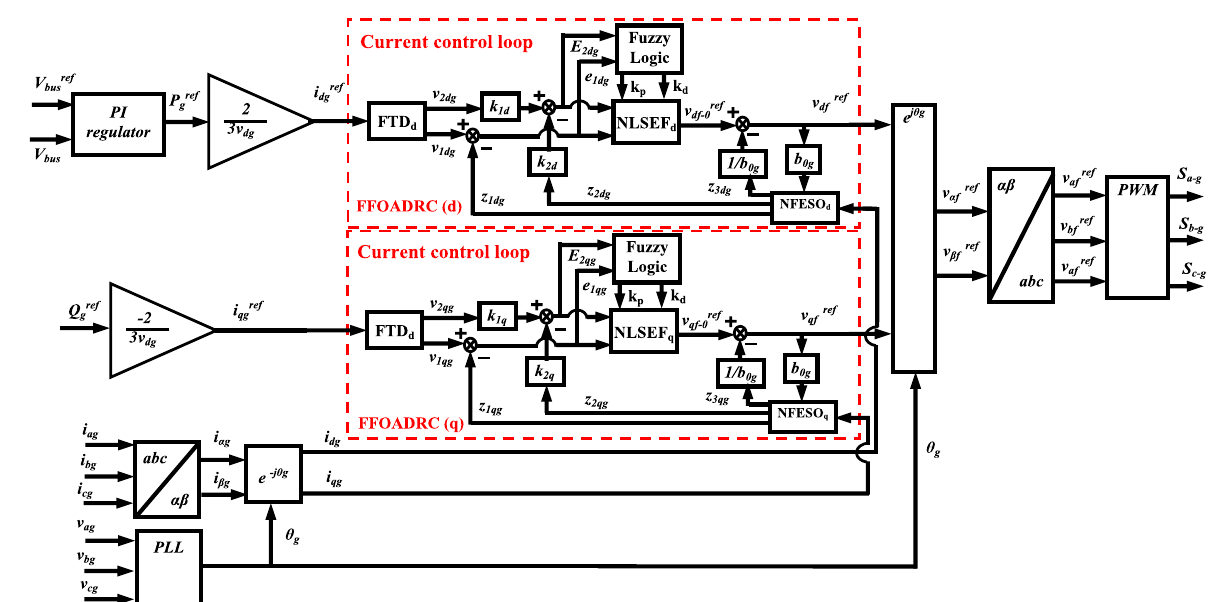
Fig. 9 Vector control of the GSC using the